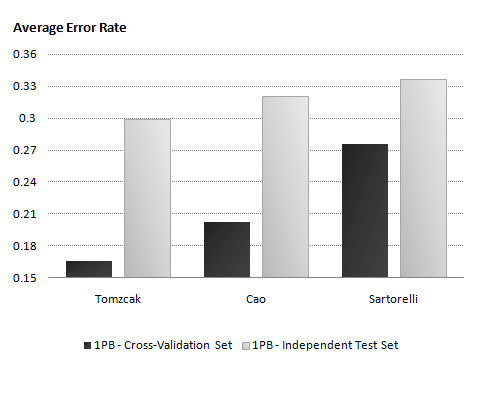
The investigation of inference of adding more complexity to the model. We investigated the inference of adding more complexity to the model by adding 50 randomly selected genes as uninformative on 1PB classifier performance. In this figure we compare the average error rate of 1PB classifier after adding 50 uninformative genes to the model.